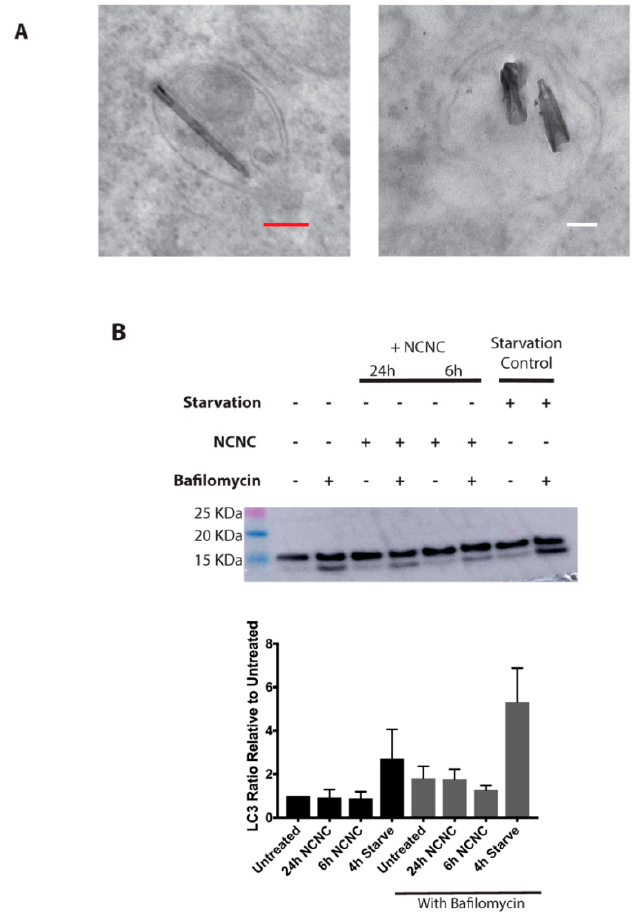
Figure 6. Autophagic response of cells exposed to NCNCs. ( A ) Examples of double membrane autophagic vesicles containing NCNCs in HeLa cells treated with 5 µ g / mL NCNCs for 6 h (left) and 48 h (right). White scale bar indicates 100 nm, red scale bar indicates 200 nm. ( B ) Representative western blot proving for autophagy marker LC3. For NCNC treatments, HeLa cells were incubated with 2 µ g / mL of NCNCs for either 6 h or 24 h. For starvation treatment, cells were nutrient starved for a duration of 4 h. Bafilomycin (100 nM) was added the last 2 h of treatment in specified conditions. Graph is a quantification of bottom band / top band ratios of four separate western blot experiments.